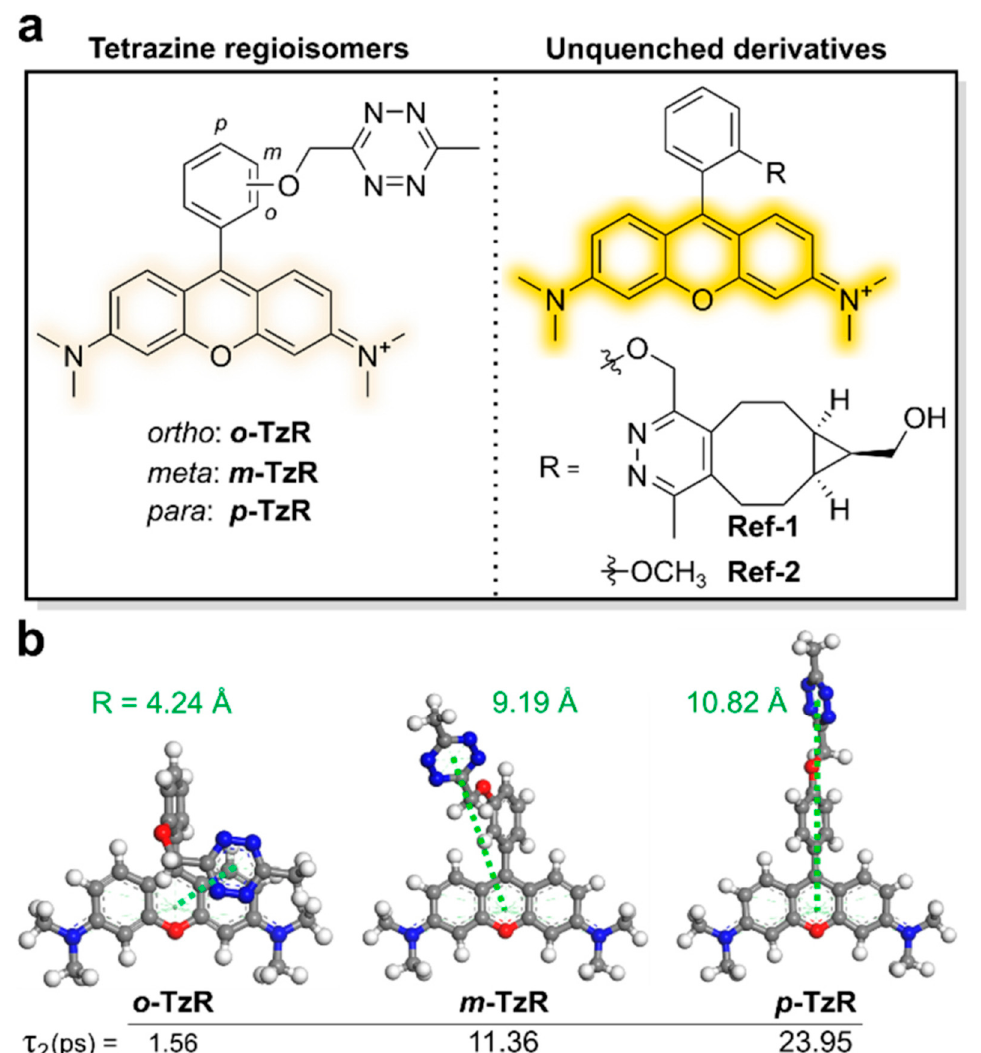
Figure 3. Molecular-design strategy for Dexter-type fluorogenic tetrazine probe. ( a ) Chemical structures of tetrazine isomers and unquenched derivatives of rhodamine dyes. ( b ) Density functional theory (DFT)-optimized structures of regioisomers and expected intermolecular distances between their tetrazine units and xanthene core. Reproduced from [39].